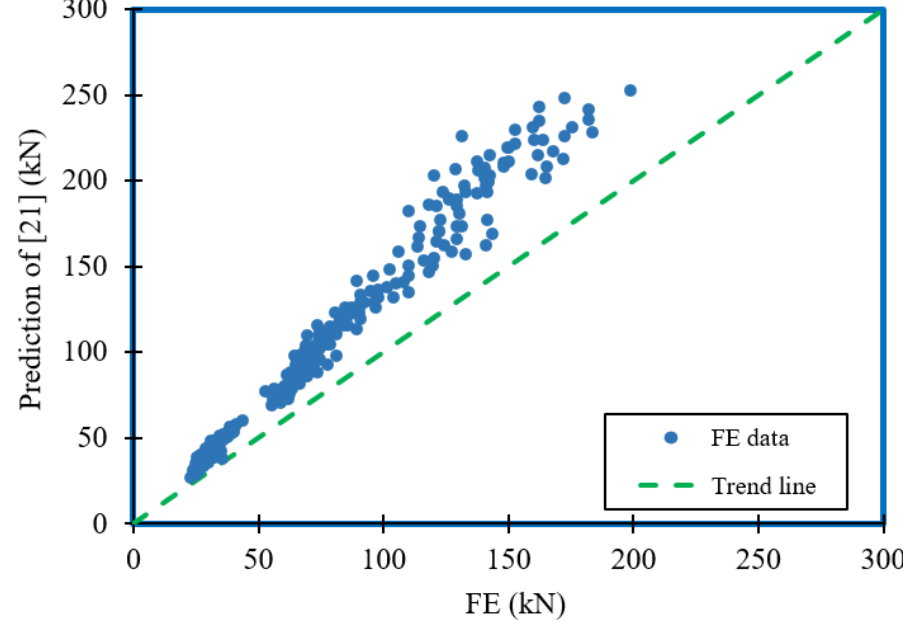
Figure 23. Comparison of parametric results and equation developed by [21].